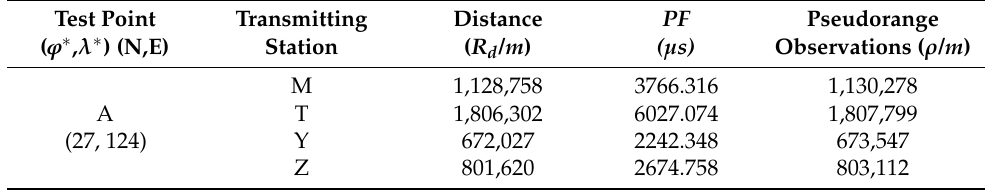
Table 3. Distance information from point A to each